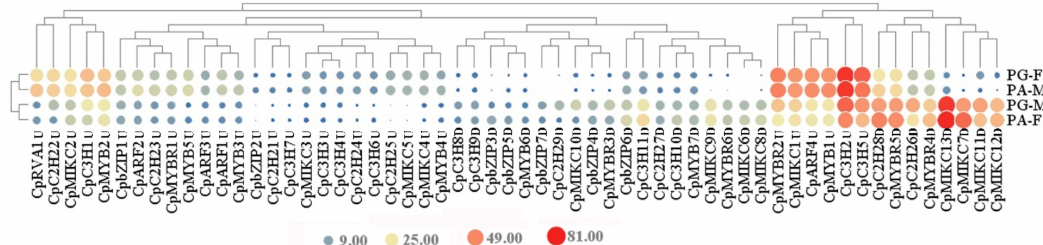
Figure 8. Heat map diagram of relative expression levels and classification based on the expression patterns of di ff erentially-expressed transcription factors (DETFs) related with flowering. The name of each gene is su ffi xed with “U” or “D”. “U” represented up-regulated in the first flowers, “D” represented down-regulated; the circle size represented the level of expression, while red represented high expression, and blue represented low